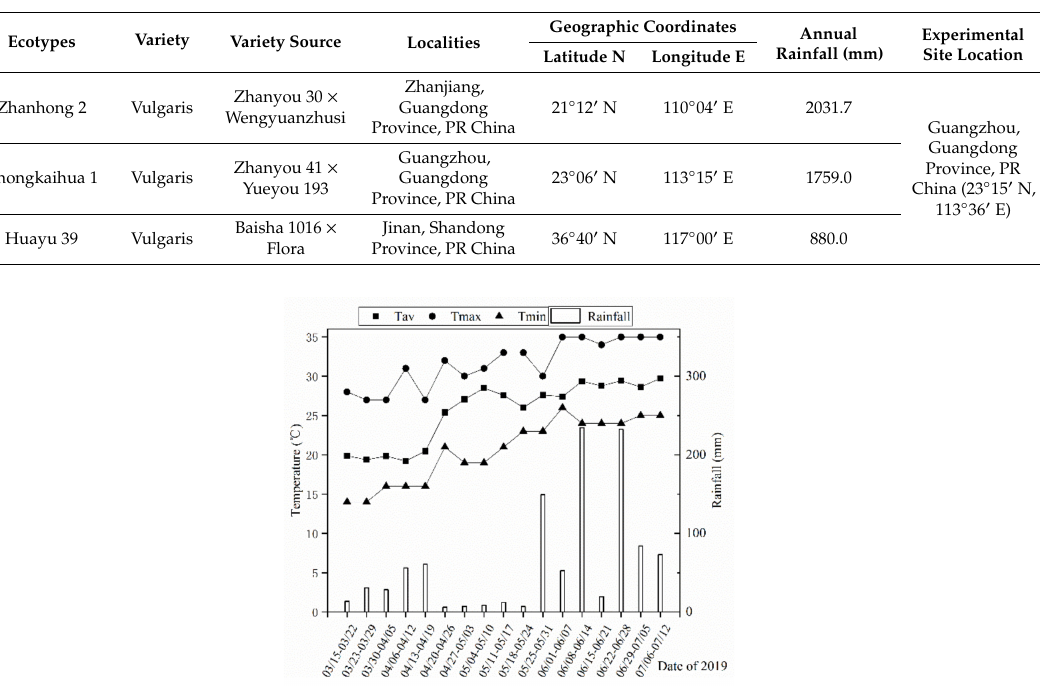
Table 1. Geographical origin of three ecotypes of peanut, average rainfall in the last five years, and the experimental site location.